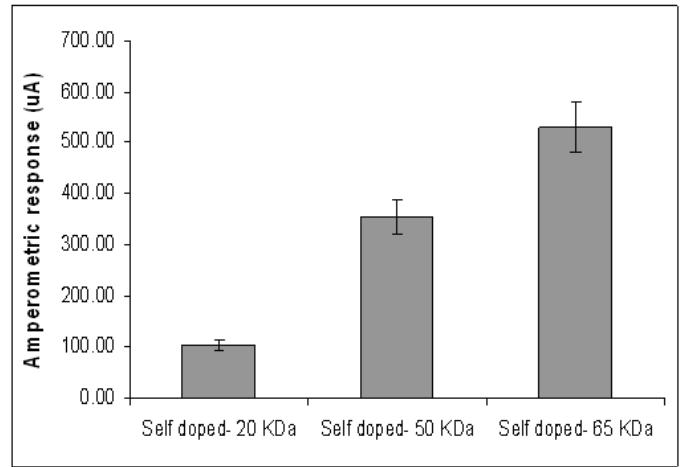
Figure 4. Amperometric responses of ITO -self doped polyaniline